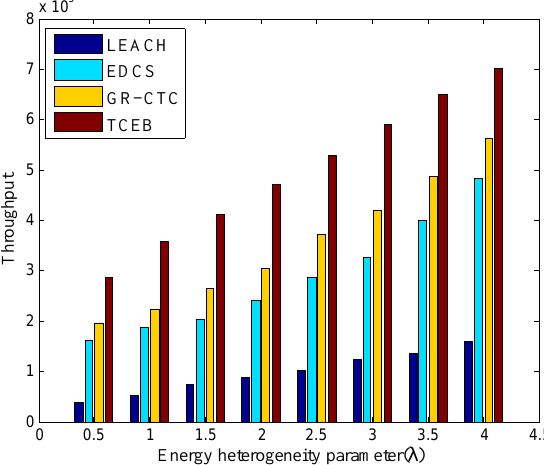
Figure 14. The comparison of throughput under different energy heterogeneity factor ( n = 200 )